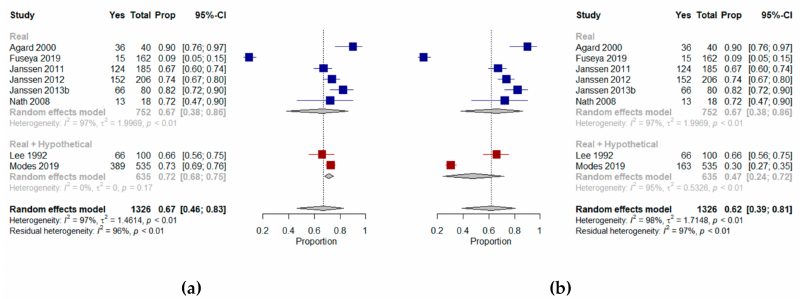
Figure 3. Forest plots comparing willingness to receive cardiopulmonary resuscitation: ( a ) Shows results (%) from studies where the context was a real scenario or both scenarios and includes the results from Modes et al. assessing patients’ preferences in their current state of health; ( b ) Shows results (%) from studies where the context was a real scenario or both scenarios and includes the results from Modes et al. assessing patients’ preference in a hypothetical state of